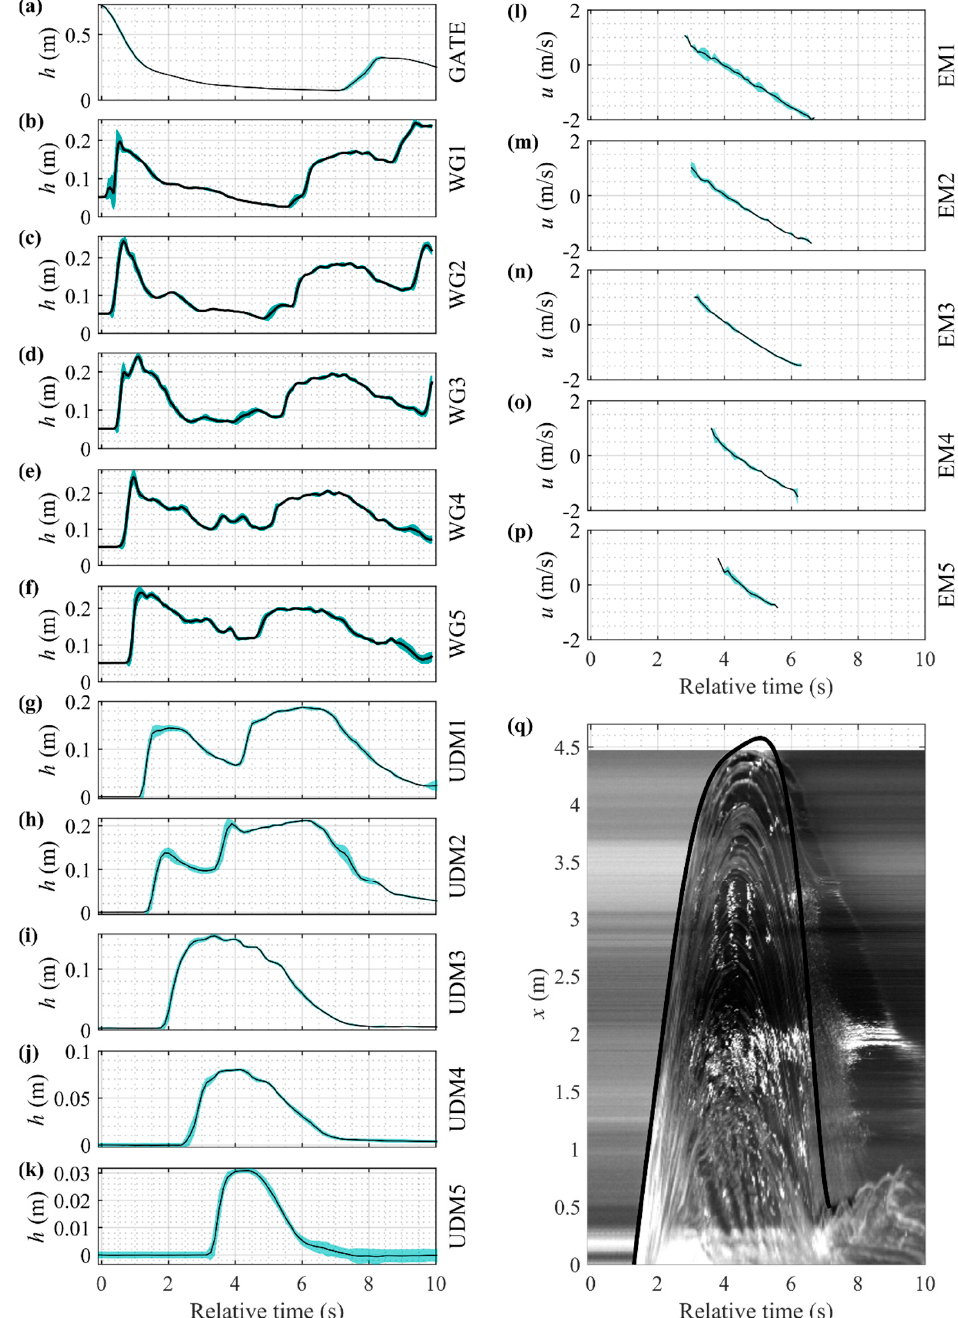
Figure 3. Ensemble-averaged time series (solid line) and +/ − 1 standard deviation (shaded area) from the 10 hydrodynamic test repetitions for water level ( a – k ) and velocity ( l – p ), and a typical cross-shore time stack and corresponding runup curve (note that the runup exceeded the field of view and was fit by cubic spline) ( q ).